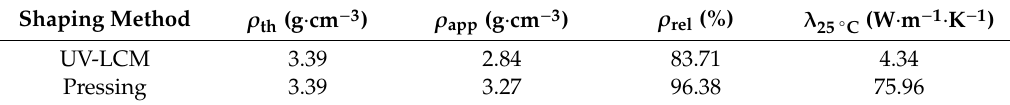
Table 4. Density values and thermal conductivity of the sintered